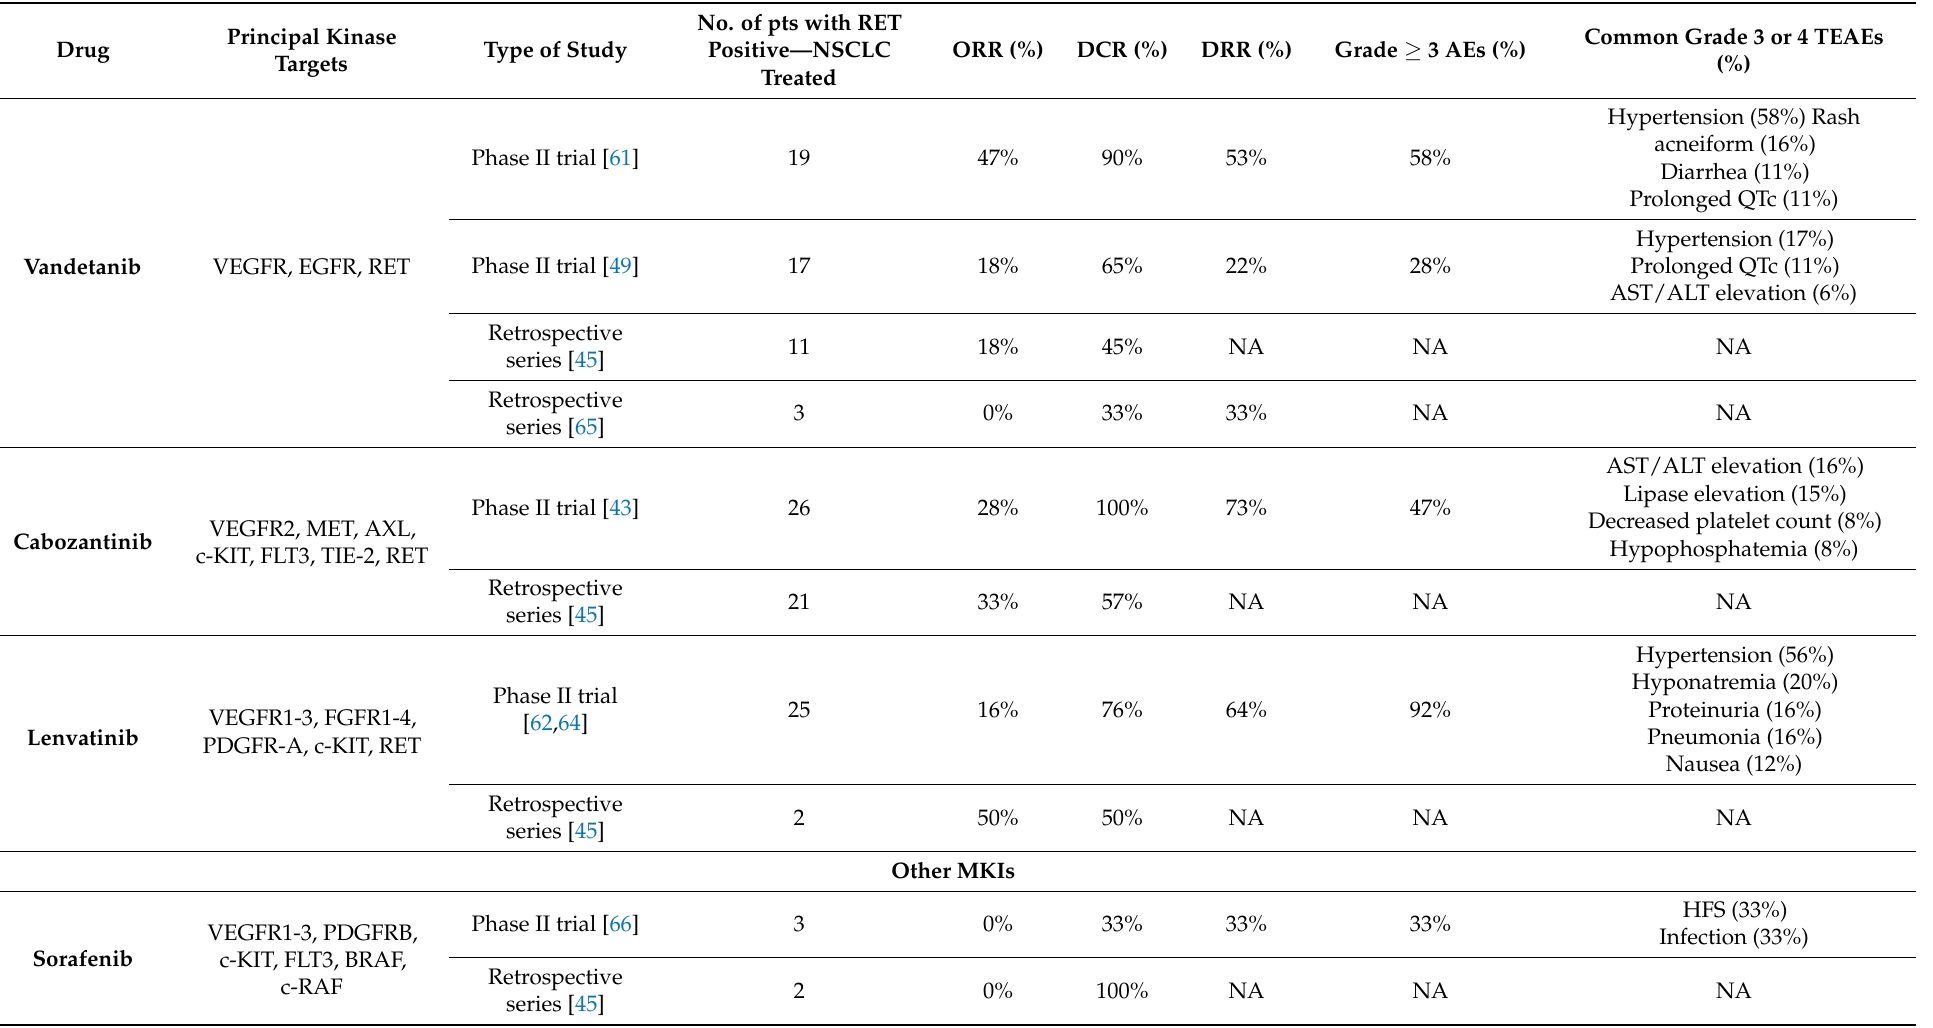
Table 2. Antitumor activity of multikinase inhibitors (MKIs) and RET-selective inhibitors in patients with RET-positive lung cancer. Data of principal clinical trials. No. of pts with RET Principal Kinase Drug Type of Study Positive—NSCLC Targets